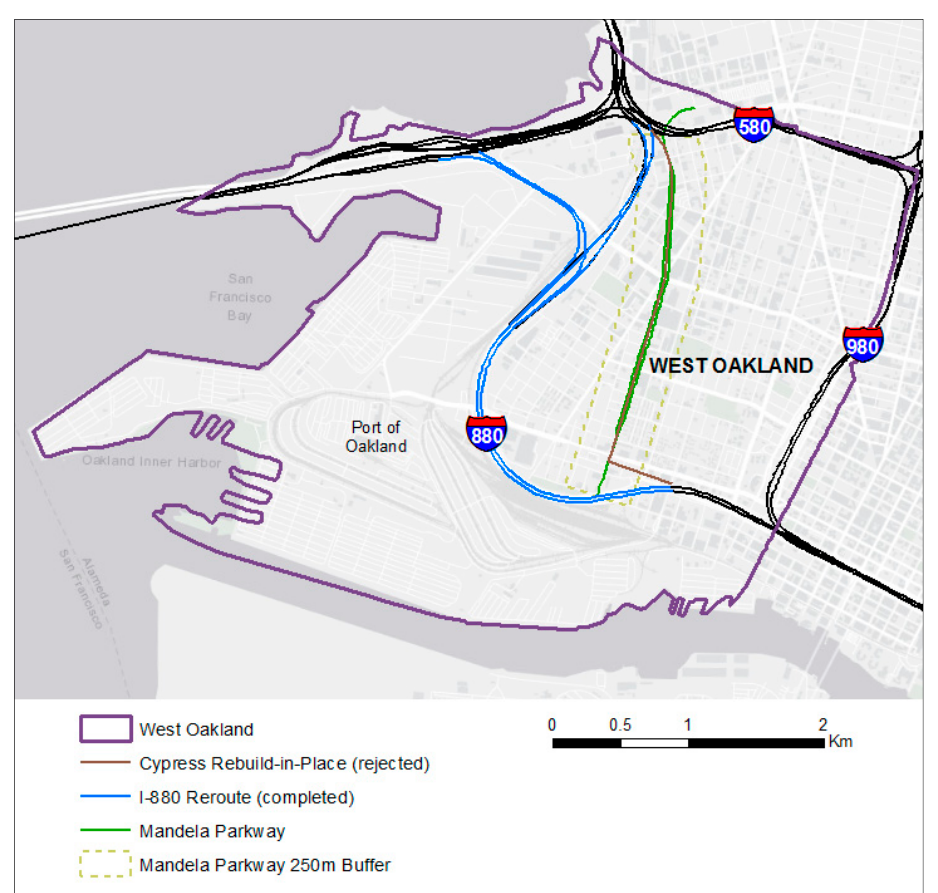
Figure 1. Map of West Oakland study area.